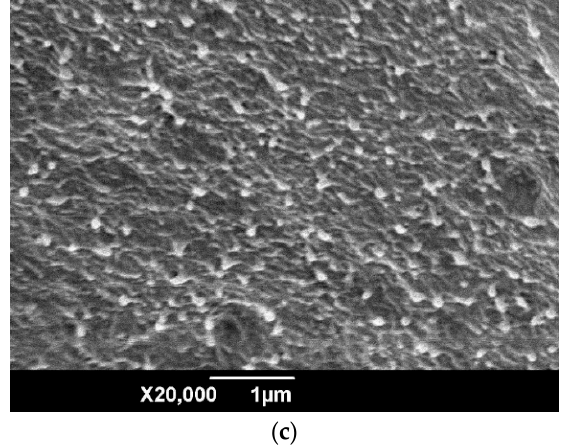
Figure 2. SEM images and Energy Dispersion Spectrum (EDS) analysis of LDPE/TiO 2 nanocomposite; ( a ) 1 wt% sample; ( b ) EDS of the 1 wt% sample; ( c ) SEM image of 5 wt% sample.